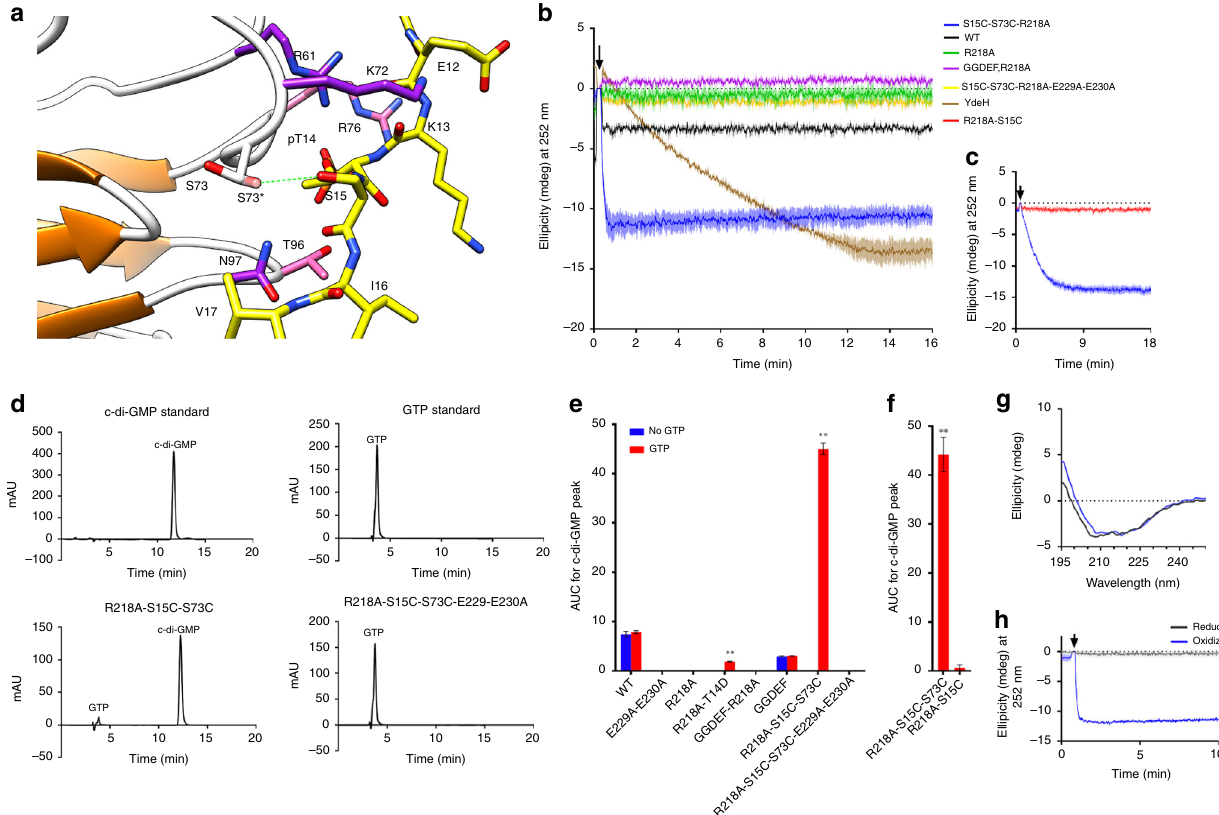
Fig. 4 Design, validation and regulation of a disulphide-activated DgcB mutant. a Design of the disul fi de mutation to lock DgcB into a constitutively active state. S15 and S73 were identi fi ed as the best candidates for mutation to cysteine residues as to facilitate the formation of a disulphide bond (a different rotamer for S73, labeled with prime, would be in an appropriate orientation to bond S15 when both mutated to Cys). b Circular dichroism assay with 10 µ M protein. Traces± standard error. Decreasing ellipticity represents increasing c-di-GMP concentration. c Circular dichroism assay with 1 µ M of both the single (R218A-S15C only) and double (R218A-S15CS73C) cysteine mutants. The single cysteine mutant has no signi fi cant activity compared to the double mutant. d HPLC traces of GTP and c-di-GMP standards, and the end products of the enzyme reactions after 40 min incubation. e HPLC activity assays monitoring c-di-GMP production at 10 µ M protein. Bars ± standard deviation. Signi fi cance between samples with and without GTP calculated by Student ’ s t -test ( P < 0.001) through GraphPad prism. f HPLC activity assays monitoring c-di-GMP production at 1 µ M protein. Signi fi cance between R218A-S15C and R218A-S15CS73C calculated by Student ’ s t -test ( P < 0.001) via GraphPad prism. Bars ± standard deviation. g Circular dichroism spectra (reporting on protein folding) of both the reduced and oxidized double mutant (at 0.1 µ M protein; signal shown is buffer subtracted). h Circular dichroism c-di-GMP assay of R218A-S15CS73C mutant using 10 µ M protein of reduced and oxidized forms (incubated with and without 12.5 mM TCEP overnight). Source data are provided as a Source Data fi